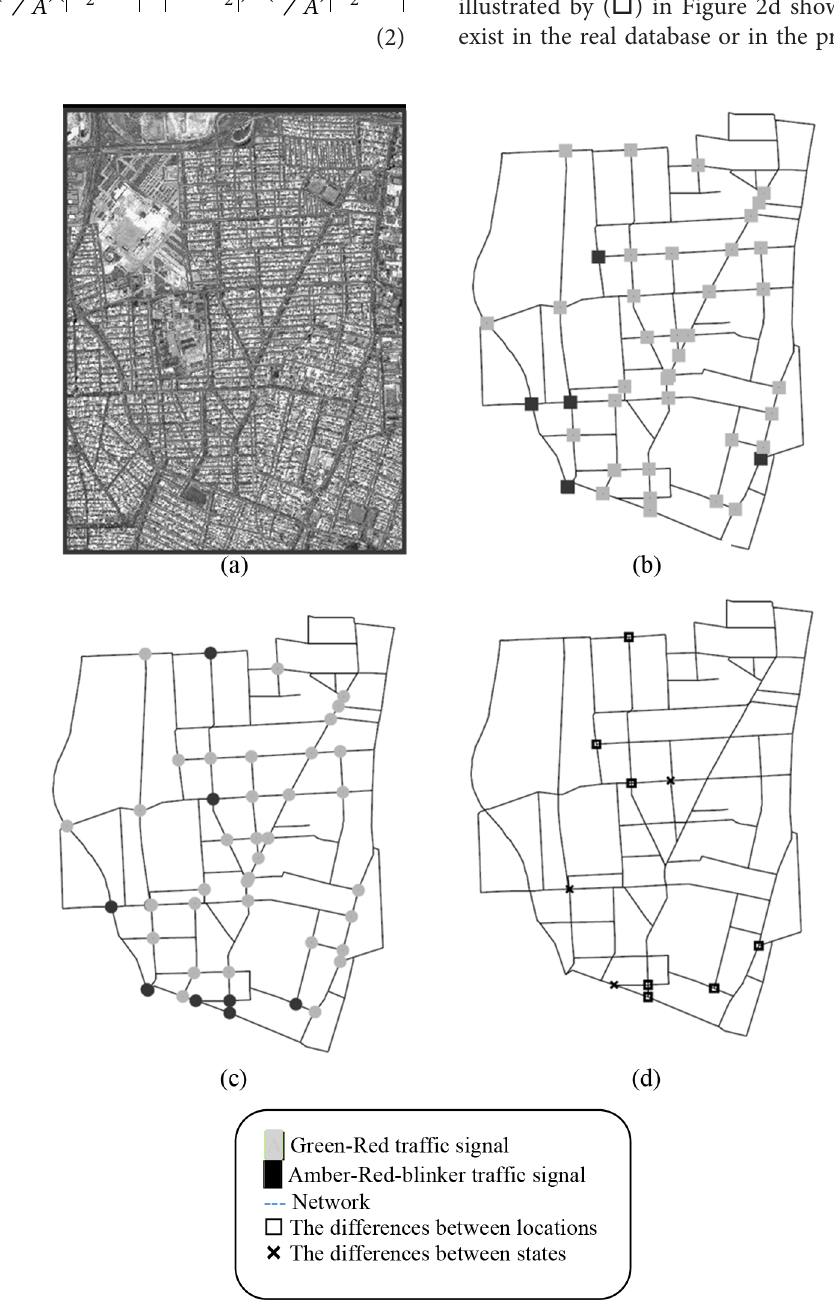
Figure 2. a) The study area, b) the real location and state of the traffic signals, c) the location and state of the proposed traffic signals, d) the comparison between the proposed method and real traffic